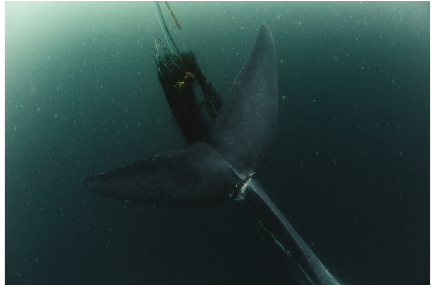
Figure 2: Blue whale entangled in large mesh drift gillnet off Mirissa, Sri Lanka, in February 2011 (photo credit: Tony